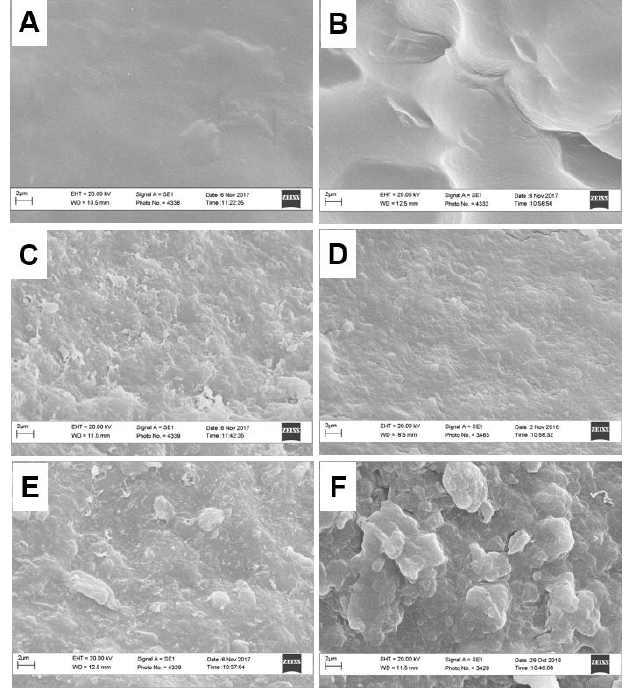
Figure 2. SEM micrographs of freeze-dried hydrogels: ( A ) H-LMP, ( B ) H-HMP, ( C ) H-LMP-HS, ( D ) H-HMP-HS, ( E ) H-LMP-HULIS, ( F ) H-HMP-HULIS.